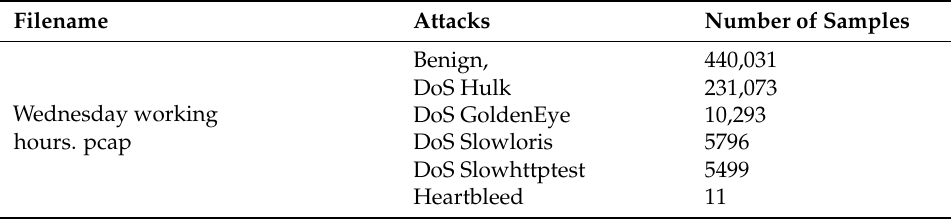
Table 3. Summary of CICDS-2017